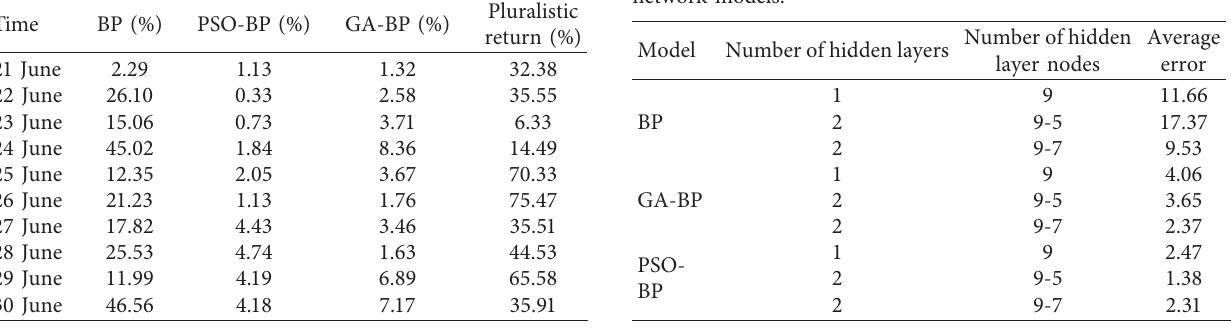
Table 6: Prediction results of different models. Table 7: Calculation results of topological structures of different network models.